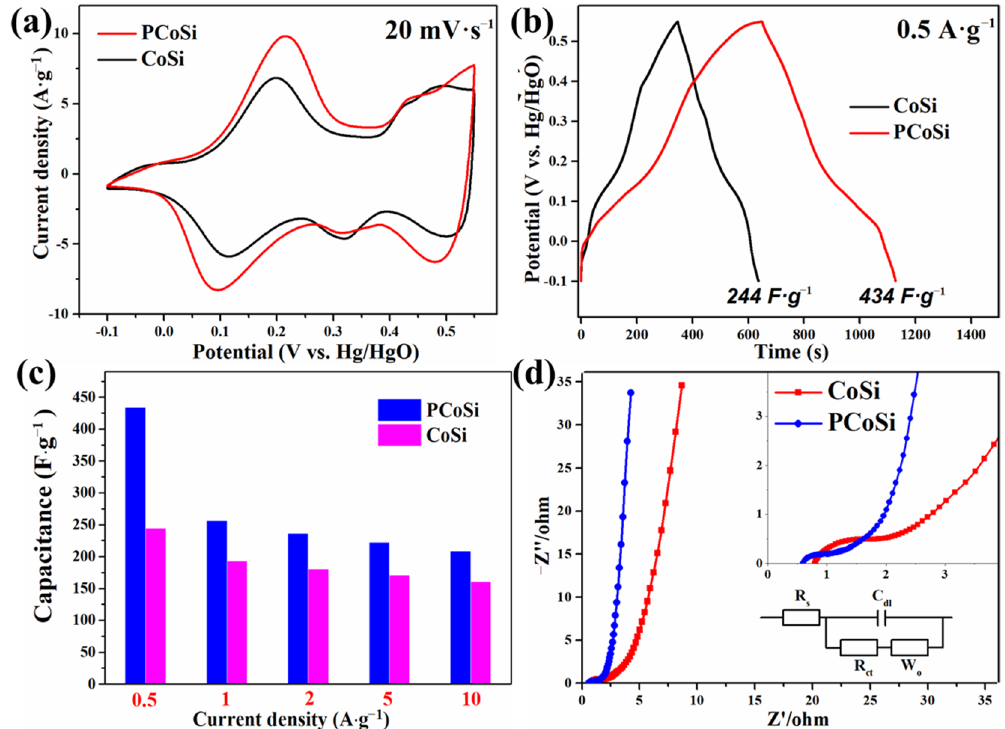
Figure 6. The compared electrochemical properties of CoSi and PCoSi: ( a ) The compared CV curves; ( b ) The compared GCD curves; ( c ) The comparison of the specific capacitance vs. current density of CoSi and PCoSi; ( d ) The comparison of the Nyquist plots of CoSi and PCoSi, inserting their correspondingly enlarged images (top right) and the equivalent circuit diagram (down